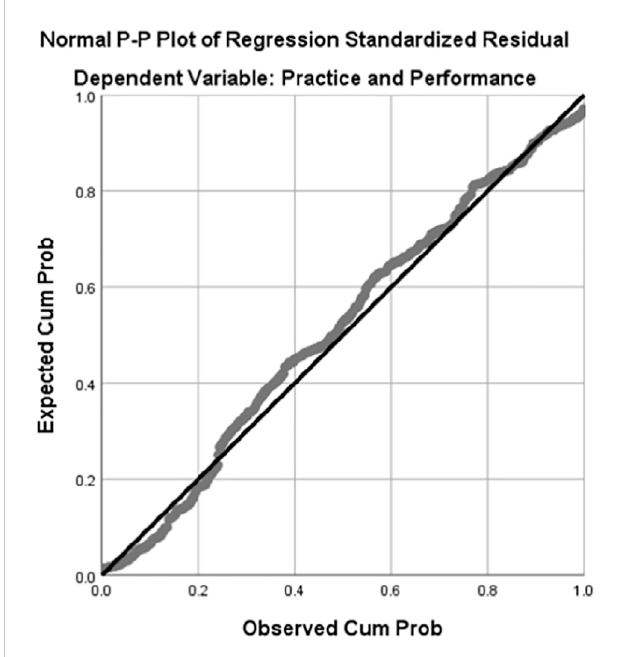
FIGURE 9 Regression ’ s P-P plot for water sector governance